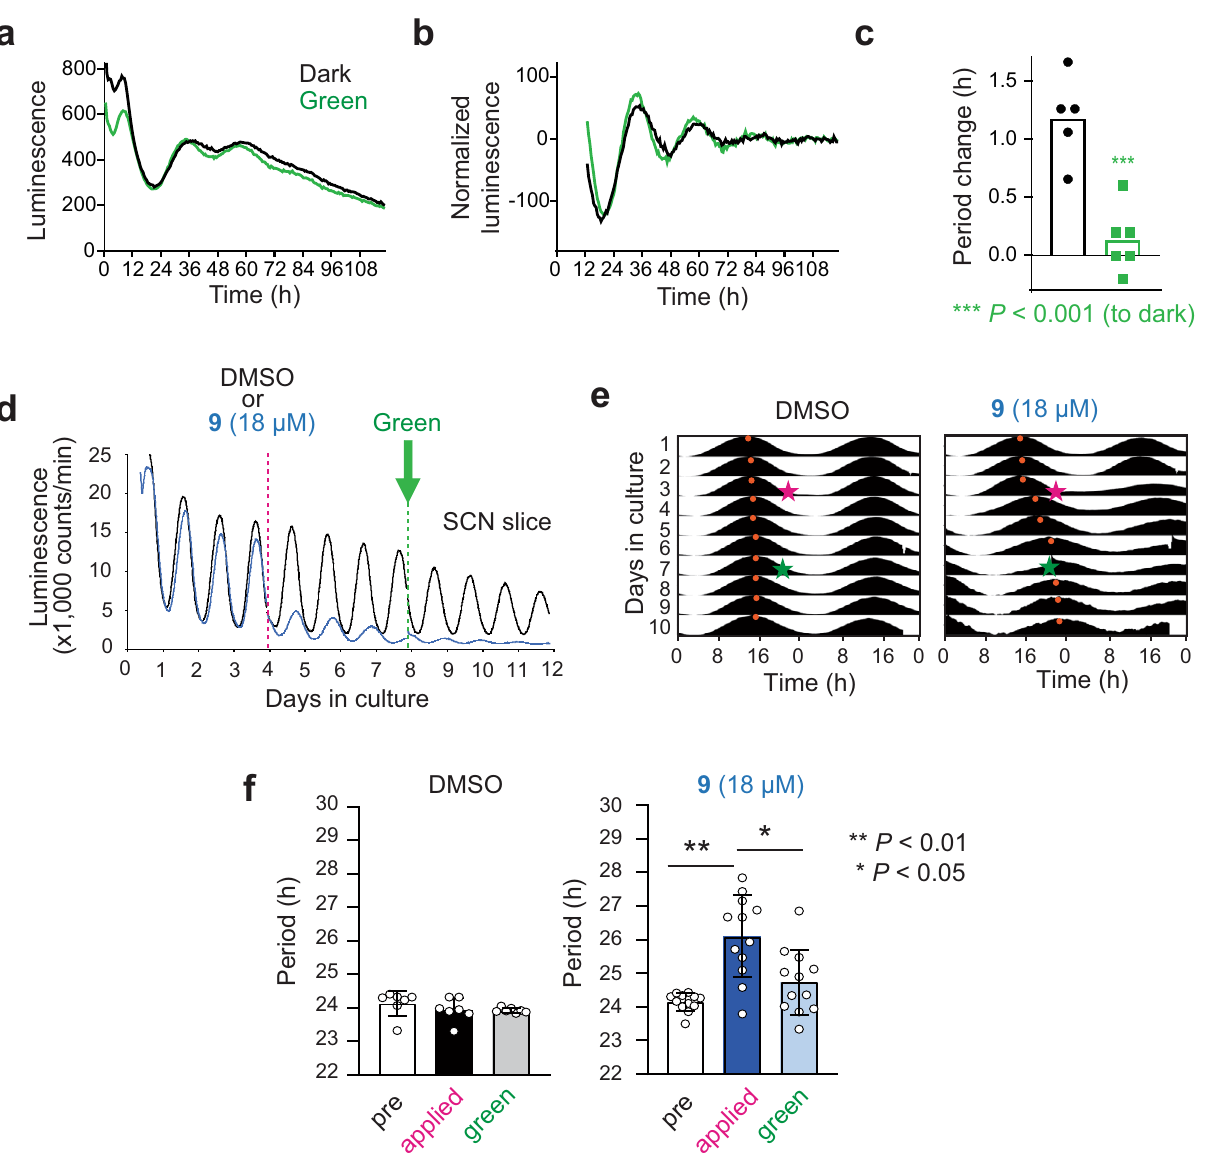
Fig. 6 Ex vivo photo-modulation of the circadian period in mouse tissue explants. a – c The spleen explants of the Per2::Luc knock-in reporter mice were applied with 12 µ M compound 9 and irradiated with green light ( λ max = 530 nm) for 0 min (dark, black) or 30 min (green). Luminescence rhythms were then monitored and shown in a (mean of n = 5 for dark and n = 6 for green light). Baseline-subtracted data are shown in b . Period changes compared to a DMSO control are plotted in c . Data for DMSO-treated tissues are shown in Supplementary Fig. 28. Luminescence is given in arbitrary units. n = 5 biologically independent samples for dark and n = 6 for green light. Two-sided Student ’ s t test was used for statistical analysis. P value is shown in the fi gure. d – f The SCN explants of the Per2::Luc knock-in reporter mice were applied with DMSO or 18 µ M compound 9 on day 4 (pink) and irradiated with green light on day 8 (green). Luminescence rhythms of a representative sample for each condition are shown in d . Baseline-subtracted and normalized data of d are shown in e . Peaks are indicated by orange dots. Period changes are plotted in f . Data are mean with SD ( n = 7 biologically independent samples for DMSO and n = 12 for compound 9 ). One-sided Friedman test with post hoc Steel-Dwass test was used for statistical analysis. P value is shown in the fi